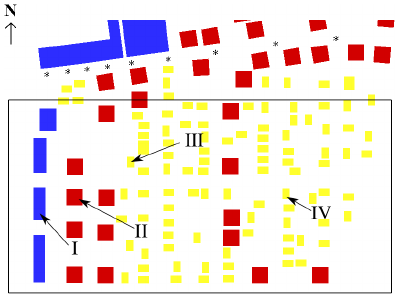
Figure 14. Representative buildings along line A.